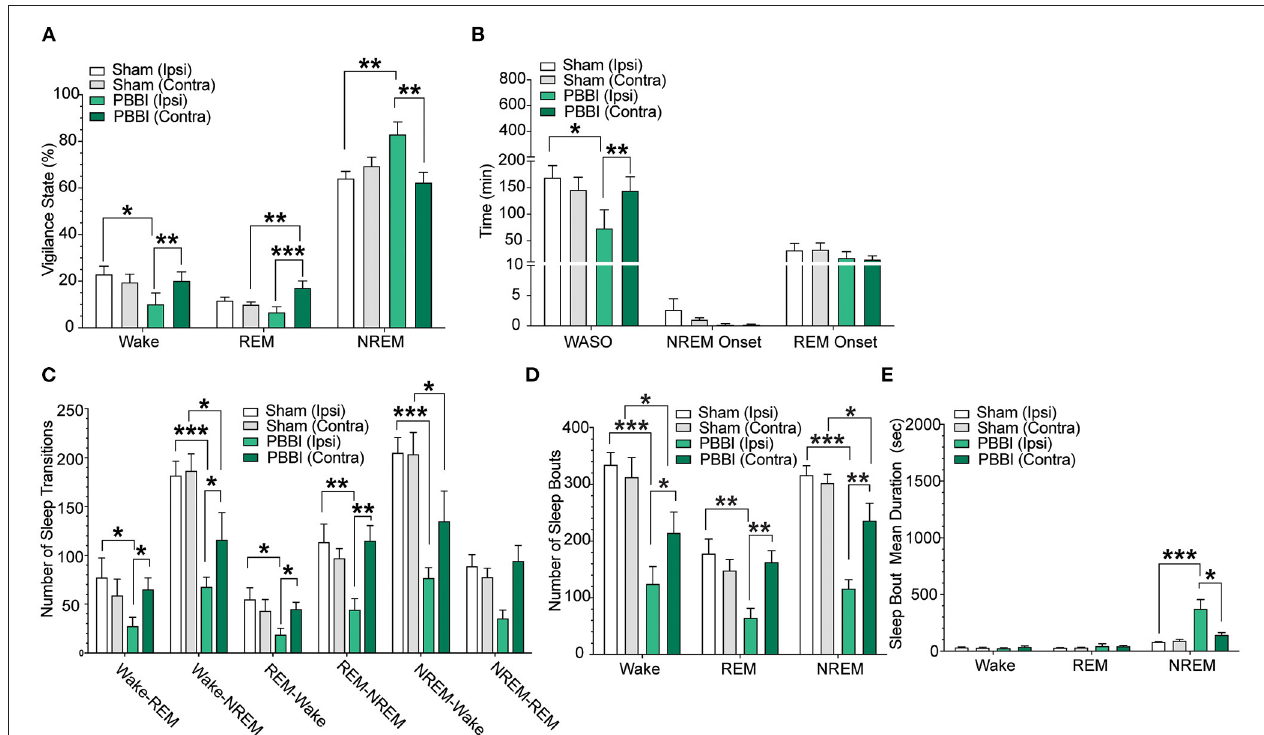
FIGURE 5 | Sleep parameters for contralateral and ipsilateral hemispheres in sham and PBBI animals in the dark phase during the acute post-injury period. Time spent in each vigilance state was collapsed over 12h bins and compared between hemispheres and injury groups. (A) PBBI rats showed significant increases in NREM sleep on the ipsilateral hemisphere only. (B) WASO, NREM onset, and REM onset were not significantly different between sham and injury groups. PBBI rats showed significant decreases in the number of (C) sleep transitions and (D) sleep bouts and increased NREM mean bout duration (E) . Significant changes were more prevalent on the ipsilateral side. N = 6 PBBI / 5 sham. All data are depicted as the mean ± SEM. WASO = wake after sleep onset (*** p < 0.001, ** p < 0.01, * p <